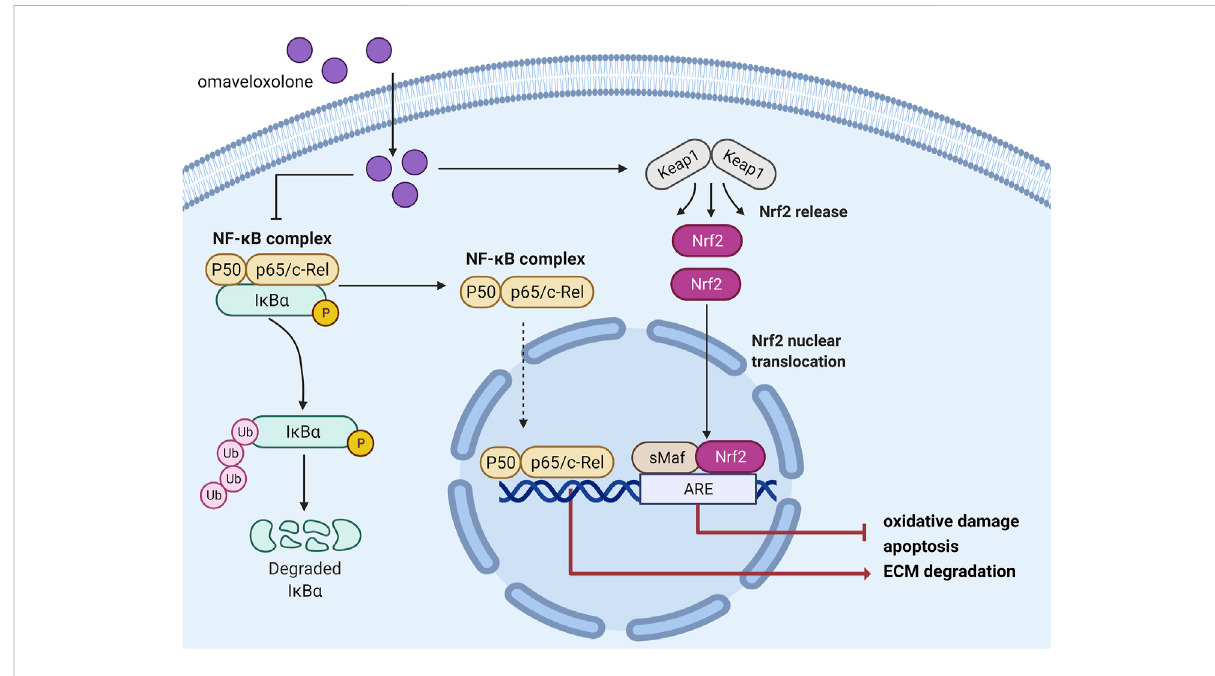
FIGURE 9 Schematic diagram of the mechanisms by which omaveloxolone affects